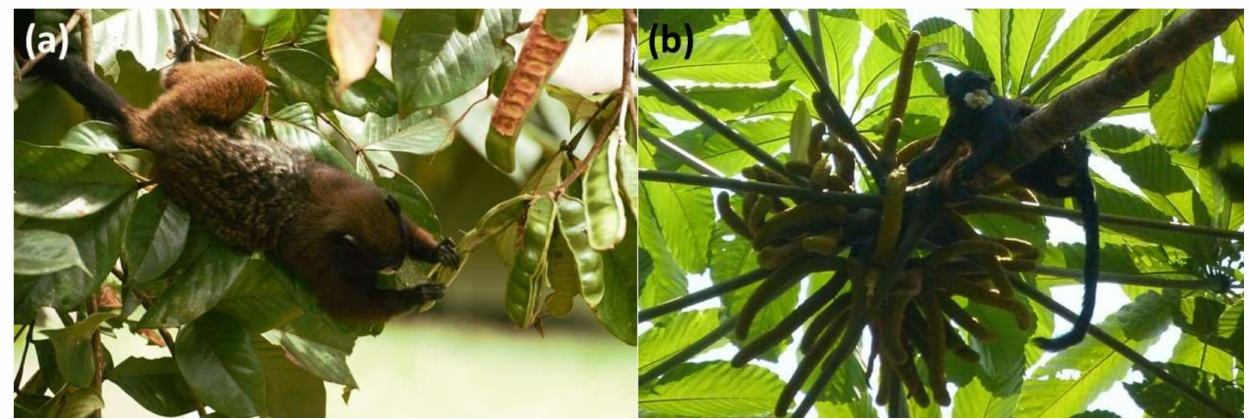
Figure 1. ( a ) Leontocebus nigrifrons feeding on Inga sp. (Fabaceae). Photo: Marco Tschapka. ( b ) Sagui- nus mystax feeding on Cecropia sciadophylla (Urticaceae). Photo: Eckhard W.